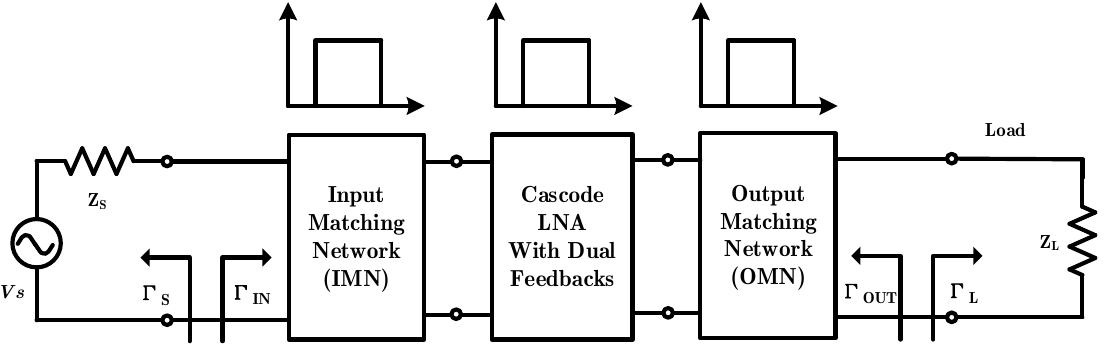
Figure 1. The block diagram of the proposed wideband LNA module.